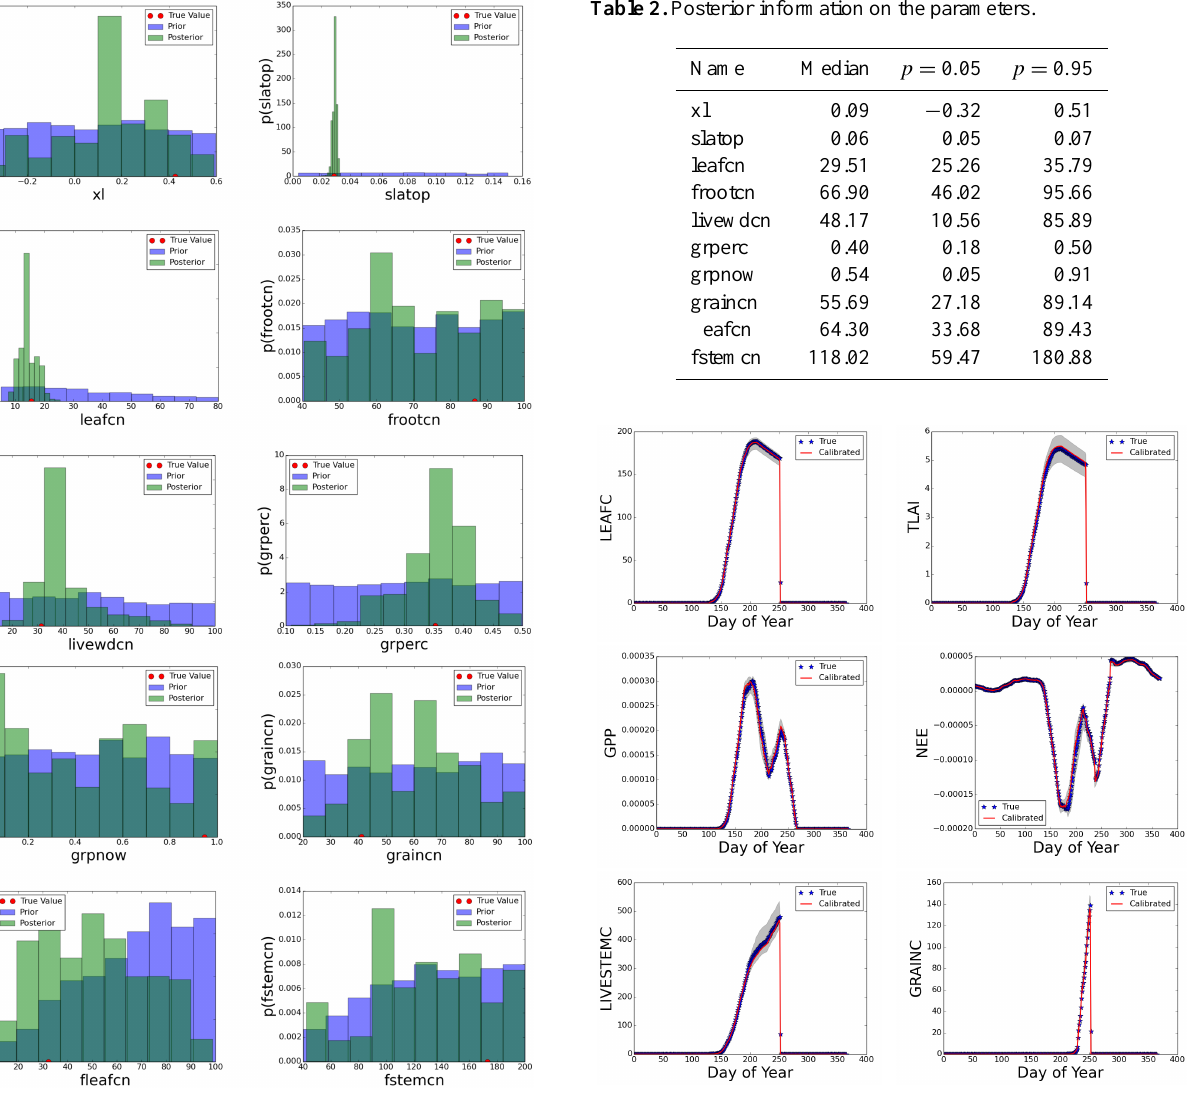
Figure 3. Twin experiment: comparison of the true model output with samples from the posterior of the